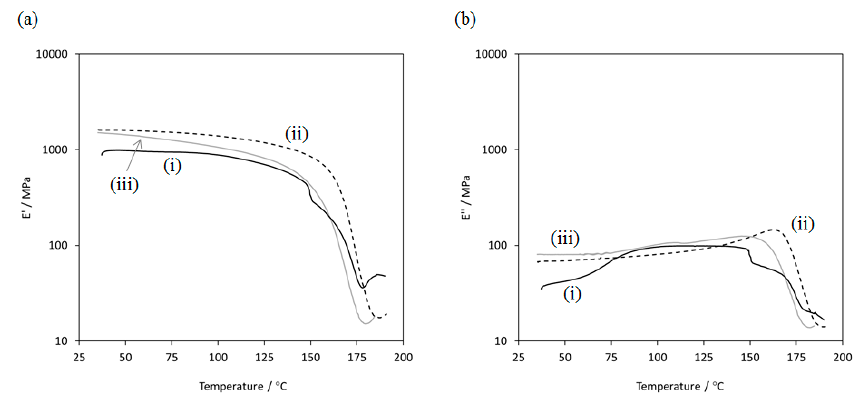
Figure 8. Dynamic mechanical analysis of (i) ATA–PTHF and (ii) ATA–PLLA supramolecular polymeric films, and (iii) potato ATA. ( a ) storage modulus (E ′ ); ( b ) loss modulus (E ′′ ).